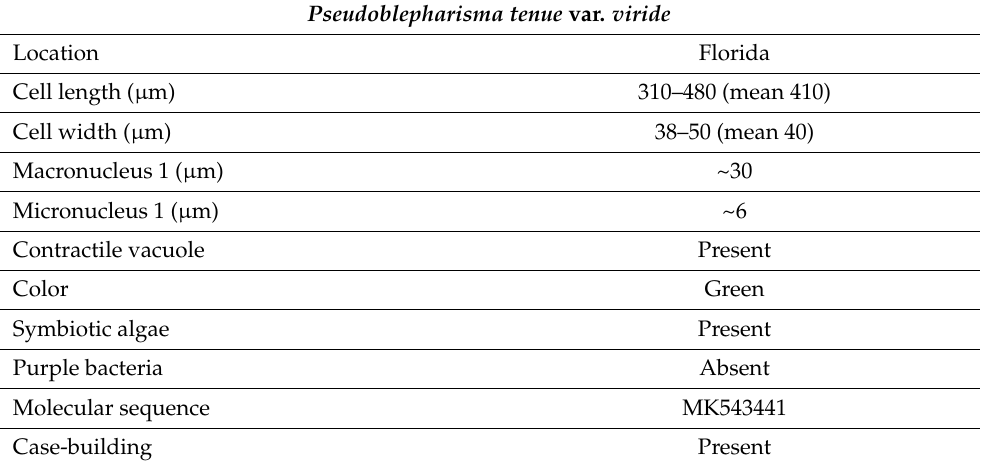
Table 1. Diagnostic features of the Florida Pseudoblepharisma tenue var. viride representative. Measure- ments were done on 30 freshly collected individual